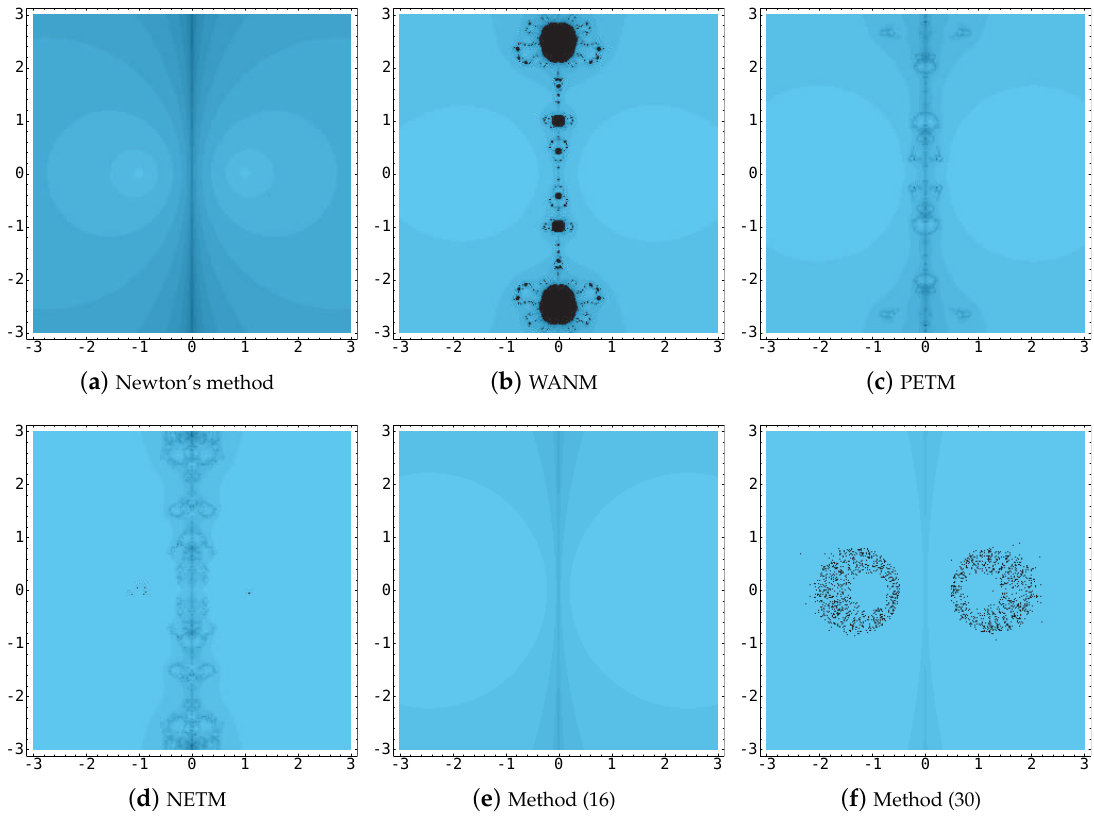
Figure 1. The results are for the polynomial z 2 −